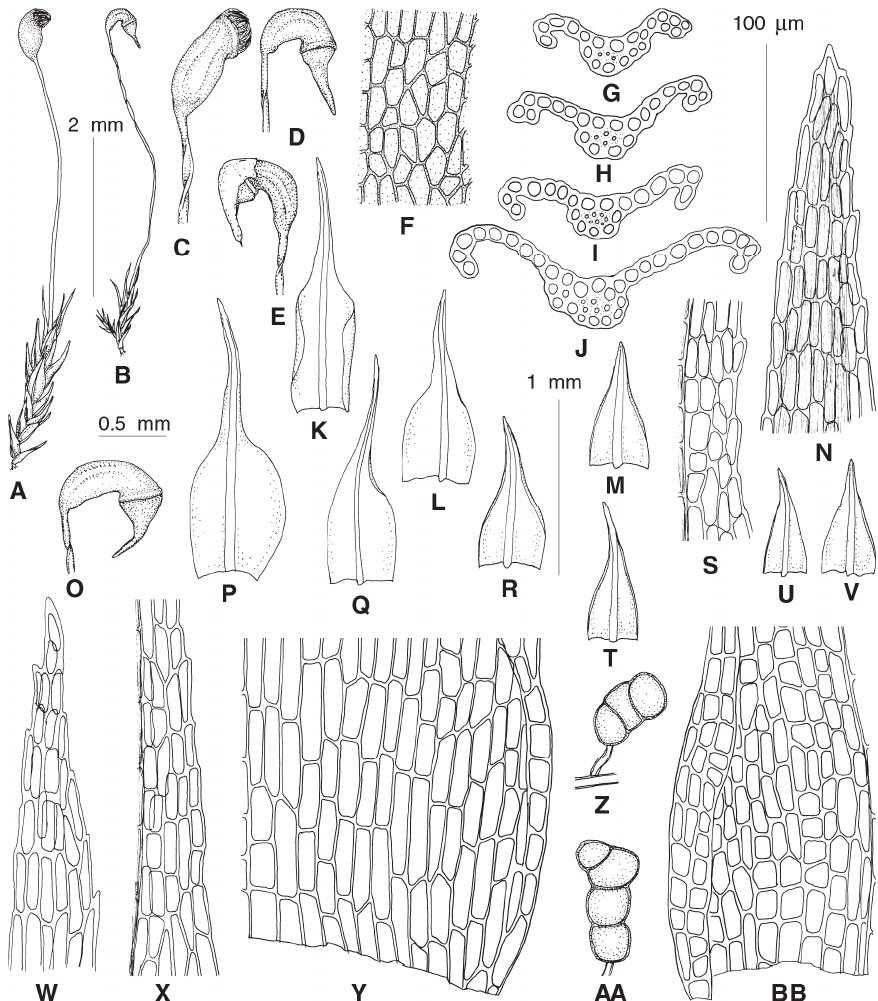
Figure 3. Line drawings of gametophyte and sporophyte of Siberian plants of Rhizogemma staphylina (from Russia: Krasnoyarsk Territory, Putorana Plateau, MW9117945, isolate FDt107): ( A ) fertile plant, wet, ( B ) fertile plant, dry, ( C – E , O ) capsules, dry, ( F ) exothecial cells, ( G – J ) leaf transverse sections, ( K , P ) perichaetial leaves, ( L , M , Q , R , T , U , V ) stem leaves, ( N , W ) upper-leaf cells, ( S , X ) mid-leaf cells, ( Y , BB ) basal leaf cells, ( Z , AA ) gemmae. Scale bars: 2 mm for ( A , B ); 0.5 mm for ( C – E , O ); 1 mm for ( K – M , P – R , T , U , V ); 100 μ m for ( F – J , N , S , W – BB ).